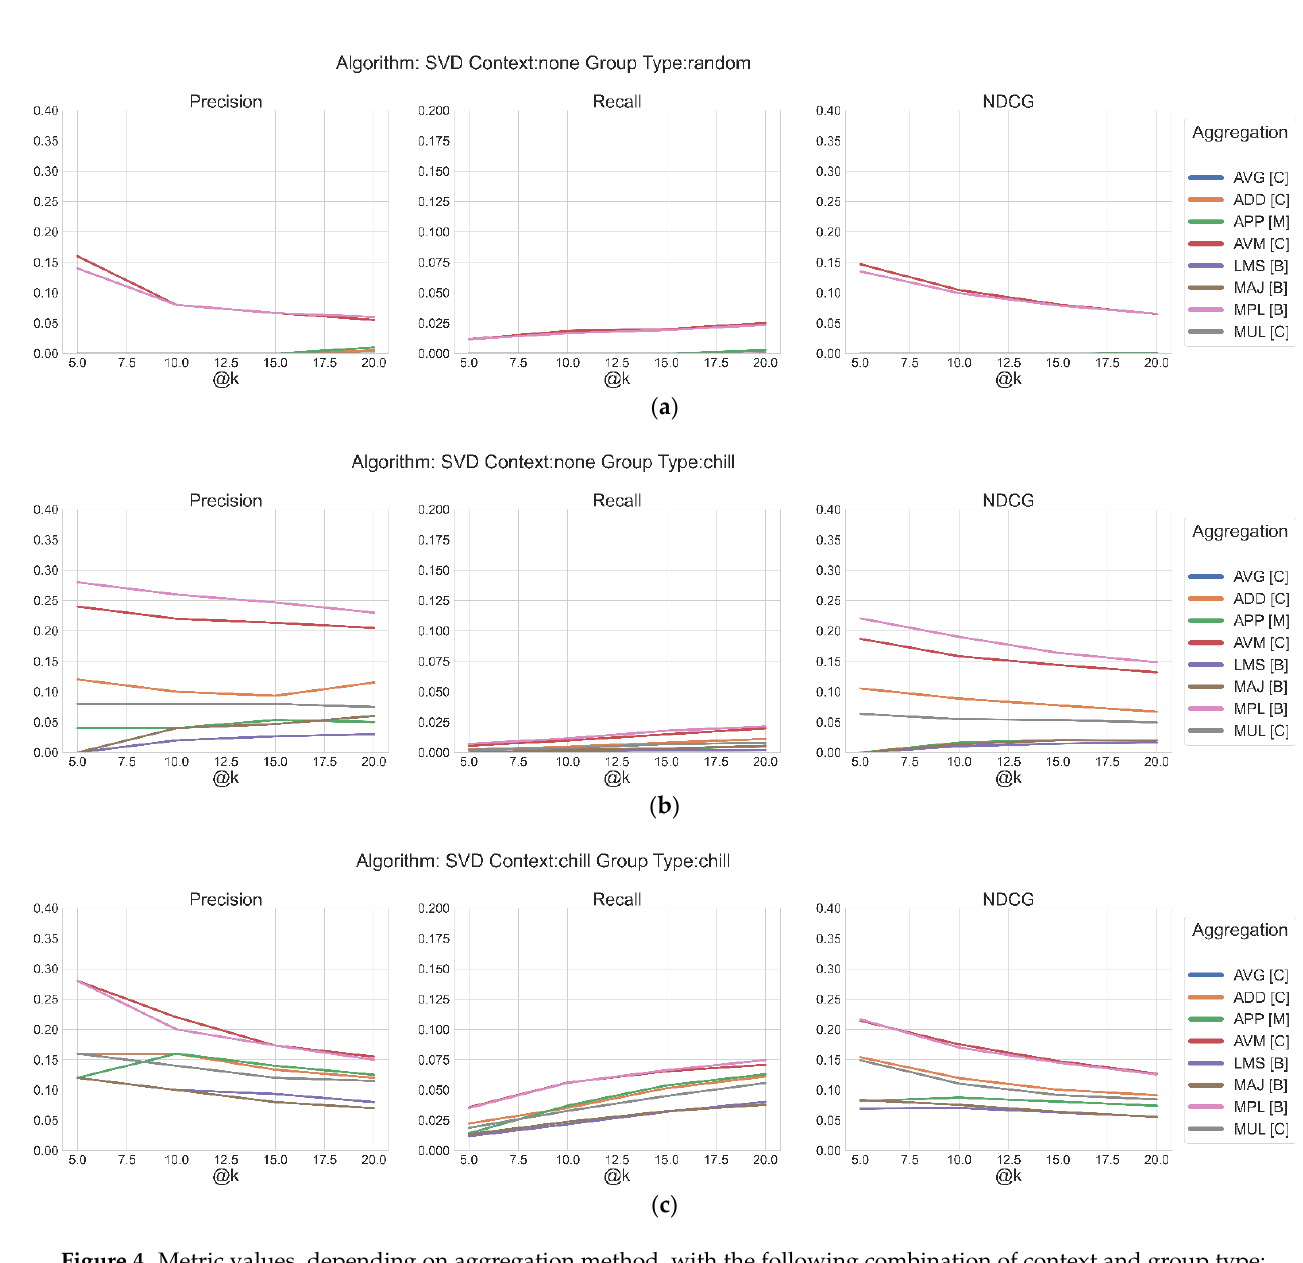
Figure 4. Metric values, depending on aggregation method, with the following combination of context and group type: ( a ) none–random, ( b ) none–chill, and ( c ) chill–chill for LFM-lb-small-spotify.